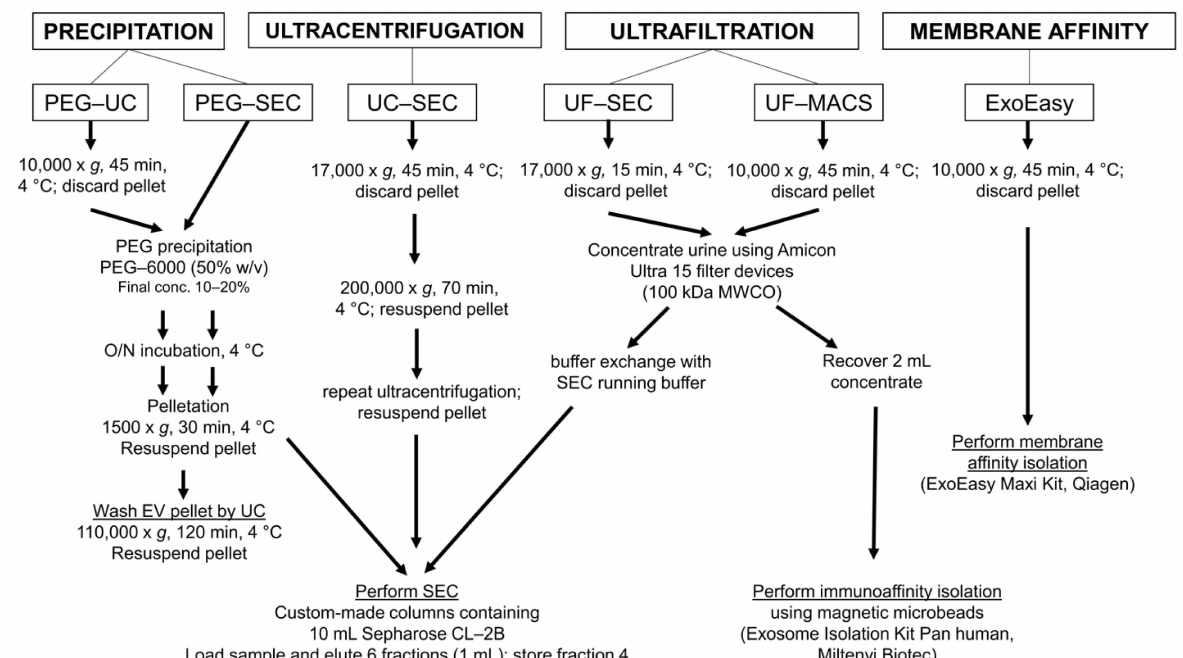
Figure 3. Experimental design of the method comparison using five different methods for uEV preparation and a sixth method for one of the void urine samples. According to published protocols, void urine samples were differently pre- processed, either at 10,000 × g or at 17,000 × g . All details for the next procedures are provided. Following uEV preparation, uEV samples were analyzed by IFCM, NTA, Western blot, and transmission electron microscopy. Methods were: PEG precipitation followed by ultracentrifugation (PEG-UC) [31], PEG precipitation followed by size exclusion chromatography (PEG-SEC) [19], ultracentrifugation followed by size exclusion chromatography (UC-SEC) [15], ultrafiltration followed by size exclusion chromatography UF-SEC [32], and the commercial ExoEasy Maxi Kit (Qiagen), which is based on membrane affinity (ExoEasy). The sixth method was ultrafiltration followed by immunoaffinity capturing with commercial anti-CD9, anti-CD63, and anti-CD81 antibody-conjugated magnetic beads (UF-MACS [33]; it was only used for the preparation of EVs from one of the void urine